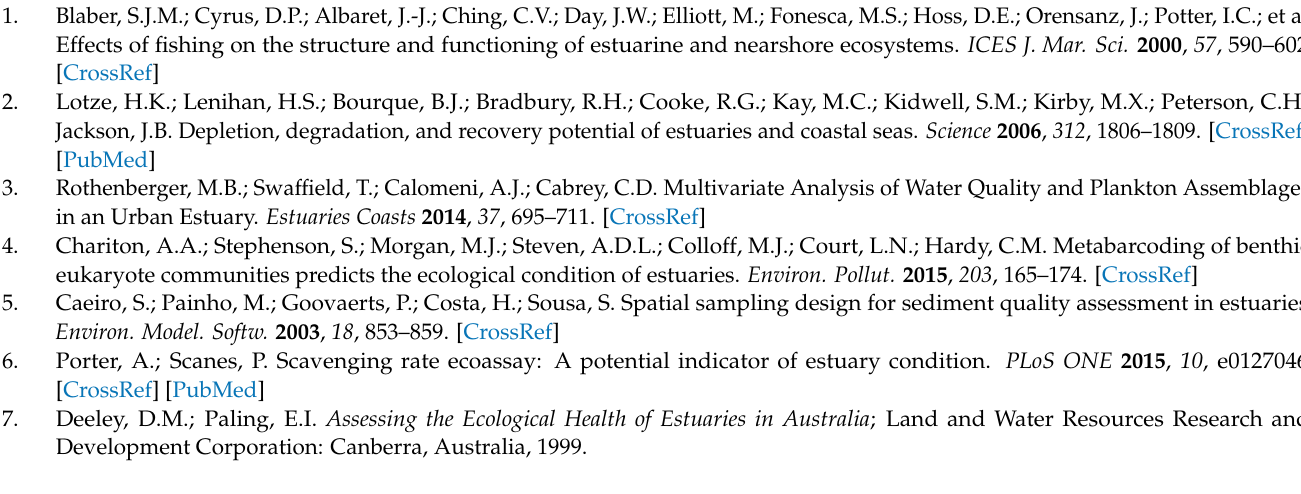
nekton assemblages in Cocagne; Table S2: Distance-based linear models (DISTLM) routine results for the analysis of the environmental variables that best describe the nekton assemblages in Shediac; Table S3: Permutational-MANOVA (PERMANOVA) pair-wise test among factor Estuary for nekton data collected from the combined data set (Community Aquatic Monitoring Program (CAMP) plus Stratified Random Design (SRD) station data); Table S4: Separate one-way analysis of variance (ANOVA) using the factor Estuary for the number of each species